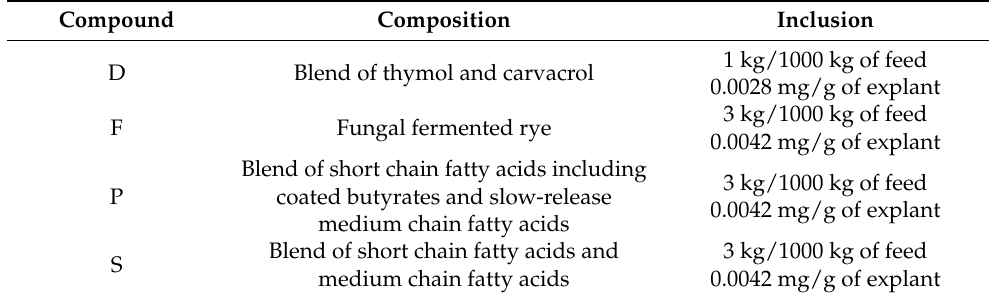
Table 1. Compound composition, inclusion in complete feed, and dilutions used in